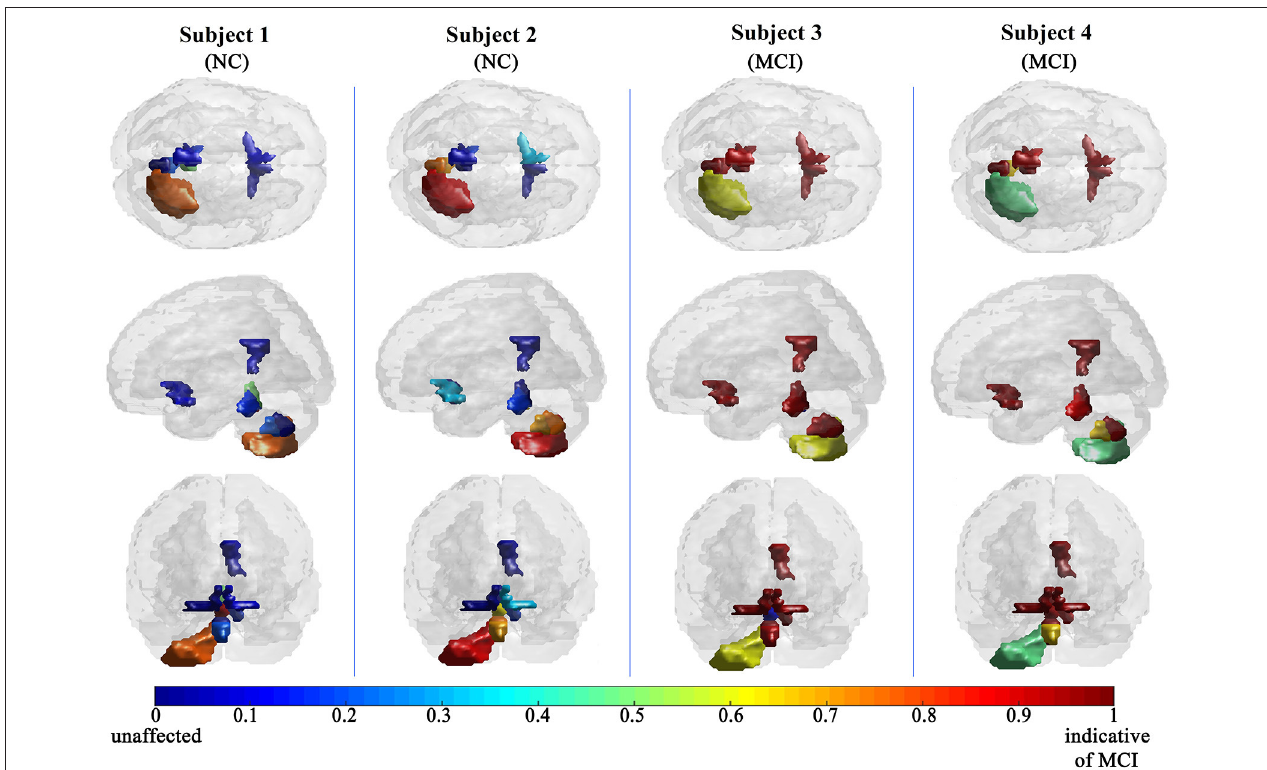
FIGURE 4 | Examples of local diagnosis results for NC vs. MCI classification problem.